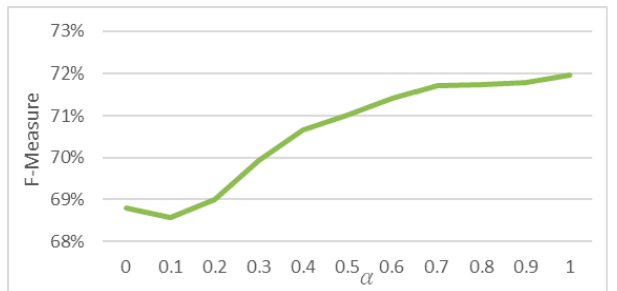
Figure 5. The effects of alpha on classification performance. Figure 5. The e ff ects of alpha on classification performance.